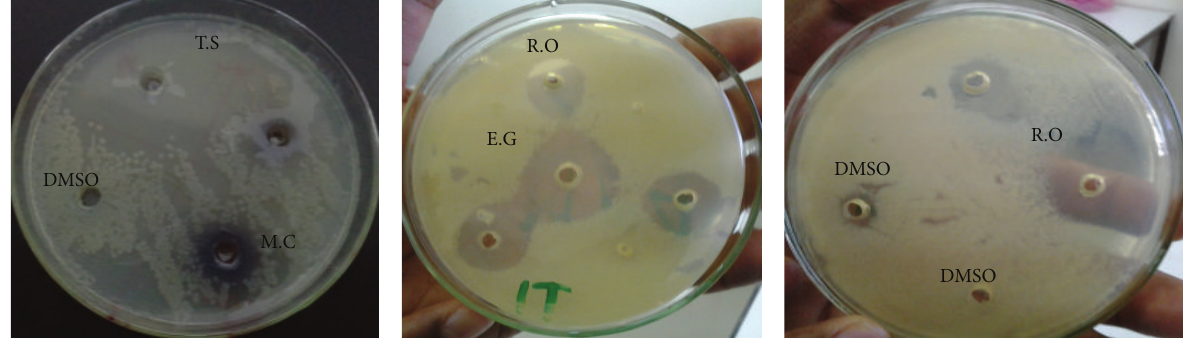
Figure 1: Growth inhibition zone on S. aureus . (T.S = Thymus schimperi , E.G = Eucalyptus globulus , R.O = Rosmarinus officinalis , M.C = Matricaria chamomilla , and DMSO = Negative